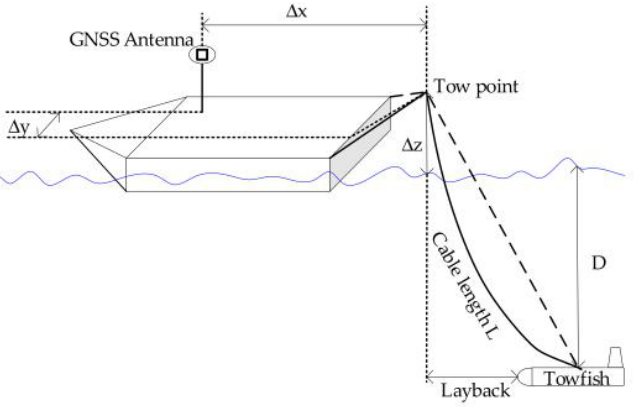
Figure 11. Schematic diagram for calculating the geographic coordinates of the